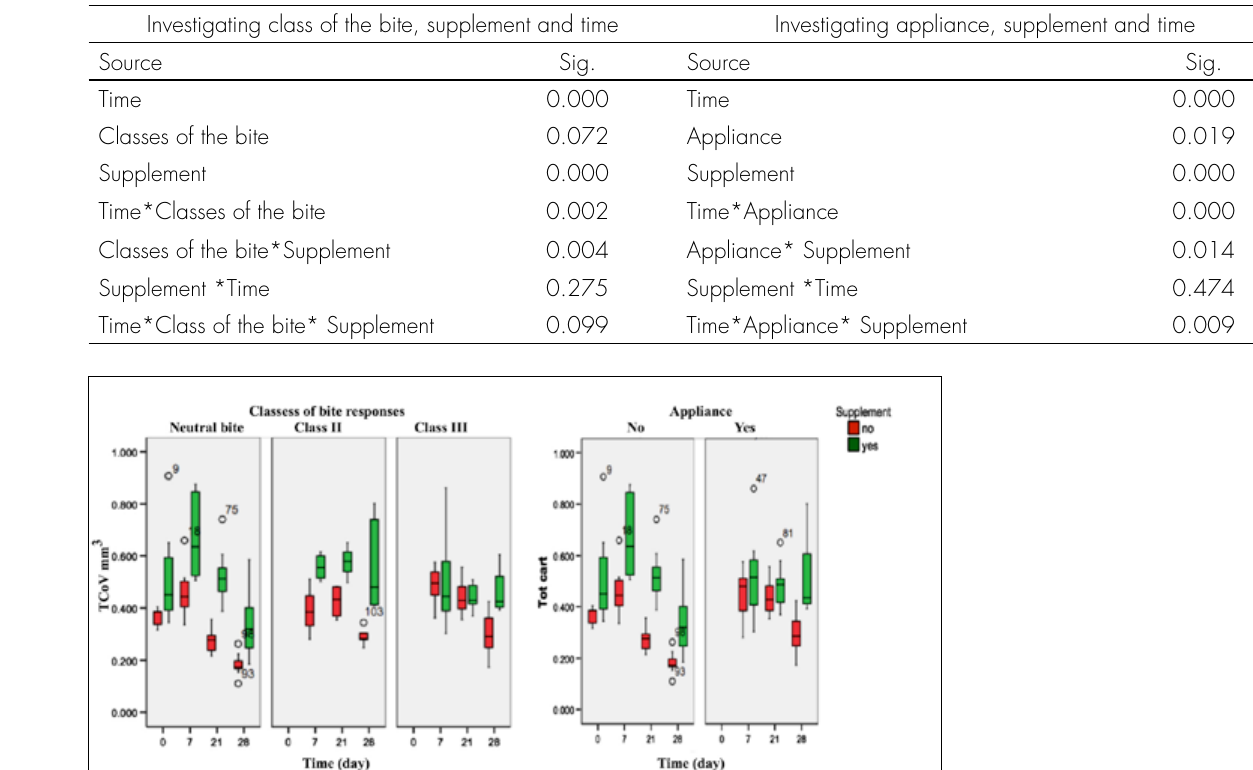
Table II. Total cartilage volume analysis (TCaV).